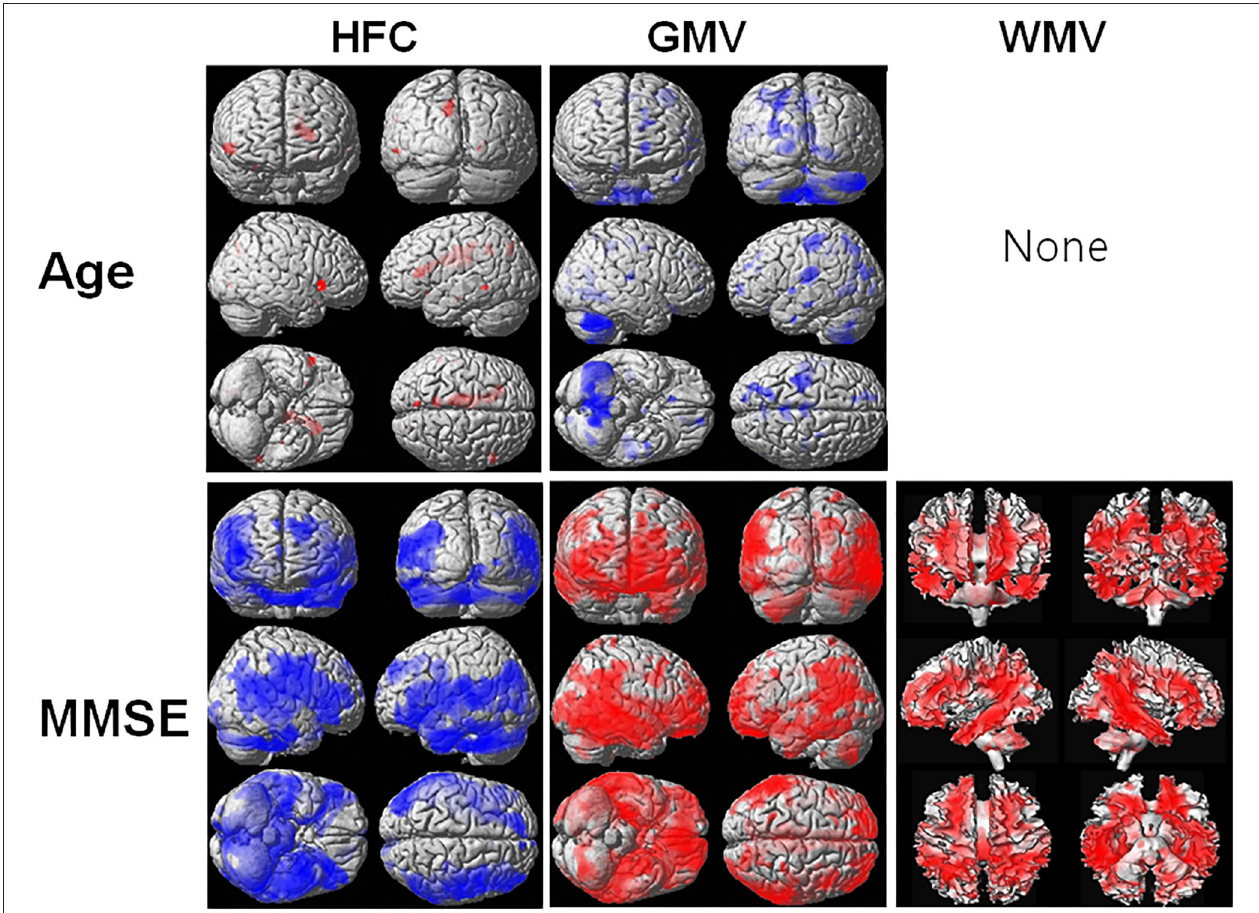
FIGURE 3 | Result of the voxel-based multiple regression analysis of the HFC or brain tissue maps with age or Mini-Mental State Examination (MMSE) scores using all participant data. The blue color indicates a negative association and the red color indicates a positive association. Details of the significantly associated areas in the brain are listed in Supplementary Table 4 with ages and Supplementary Table 5 with MMSE scores.